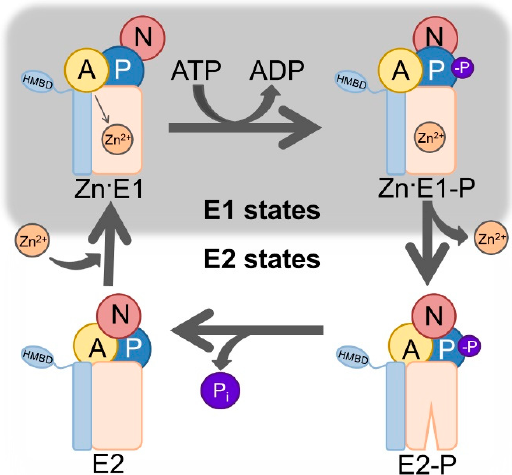
Figure 1. Post-Albers scheme of P IB-2 -ATPases. The E1 (high zinc affinity) and E2 (low zinc affinity) states of the enzyme alternate, and couple ATP (adenosine triphosphate) hydrolysis to the export of zinc. The E1 state accepts one zinc (Zn 2+ ) ion and ATP from the intracellular side, which promotes autophosphorylation, reaching the zinc occluded Zn · E1-P state and releasing ADP (adenosine diphosphate). Completion of phosphorylation triggers considerable conformational changes that opens the pump towards the outside, allowing release of zinc in the E2-P state. Metal discharge is associated with auto dephosphorylation, liberation of inorganic phosphate (P i ), and allows the enzyme to reach the E2 conformation. The domains are represented as follows: The actuator (A) domain in yellow, the phosphorylation (P) domain in blue, the nucleotide-binding (N) domain in red, the transmembrane domain in light orange. Features specific for P IB -ATPases are shown in light blue, and includes two transmembrane helices and heavy-metal binding domain(s) (HMBD).